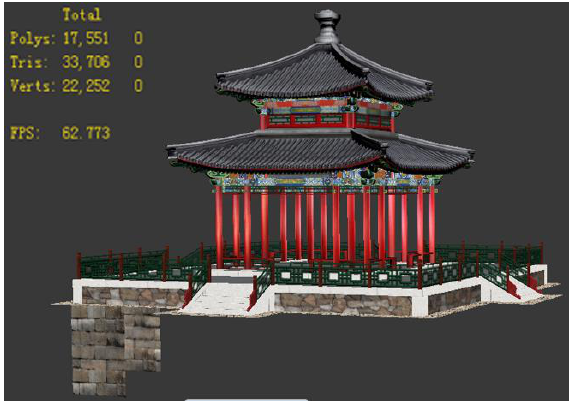
Figure 3. Current 3D Model of Liuxiangzhu